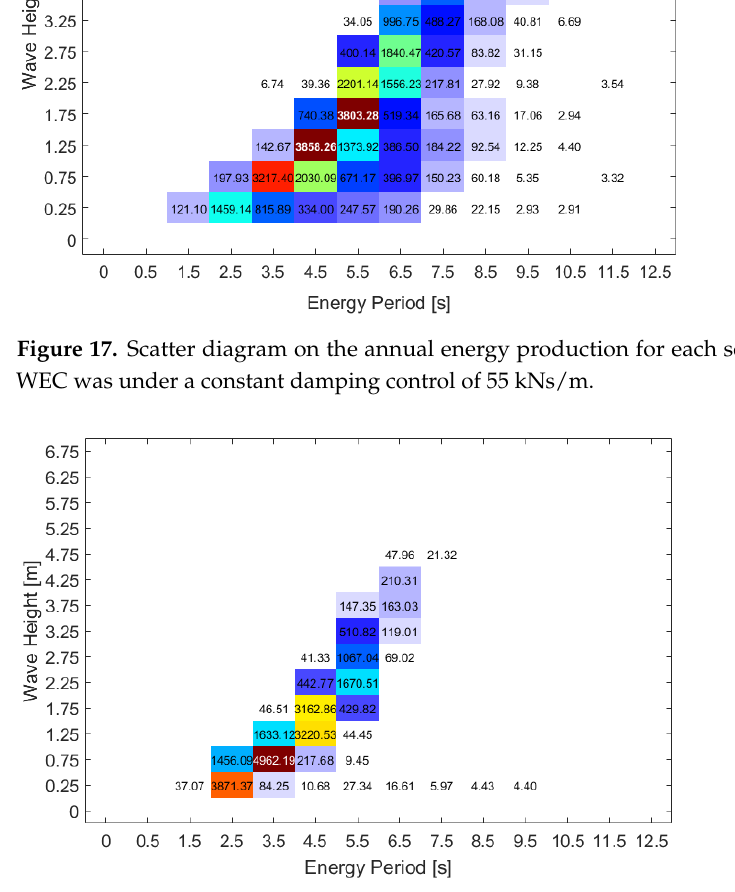
Figure 18. Scatter diagram on the annual energy production for each sea state at Site 12 when the WEC was under a constant damping control of 55 kNs/m.